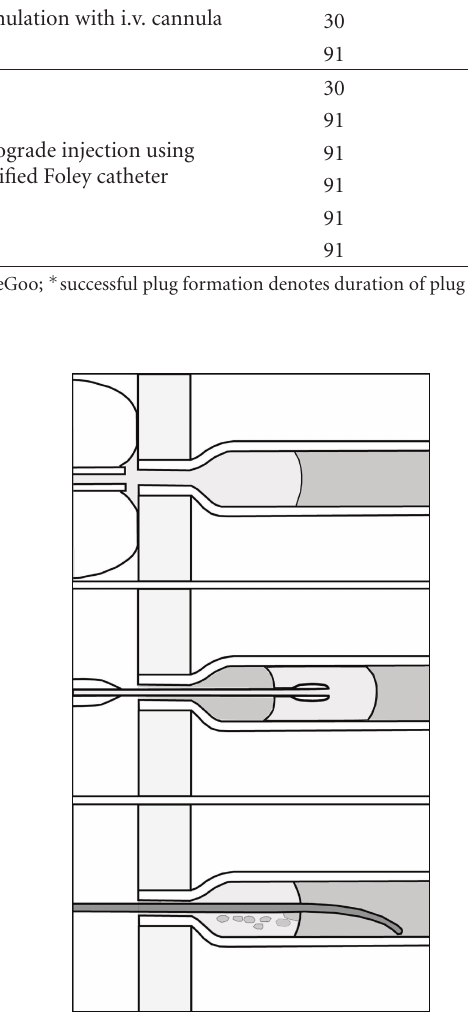
Figure 3: Principle diagram. The upper panel shows retrograde LG injection (or LG plug removal by aspiration) by the modified paediatric Foley catheter. The balloon of the modified catheter is positioned over the tube orifice. The middle panel shows LG injec- tion using the LG cannula. The lower panel shows disruption of an LG plug by a guide wire. LG is shaded with light grey and tap water darker